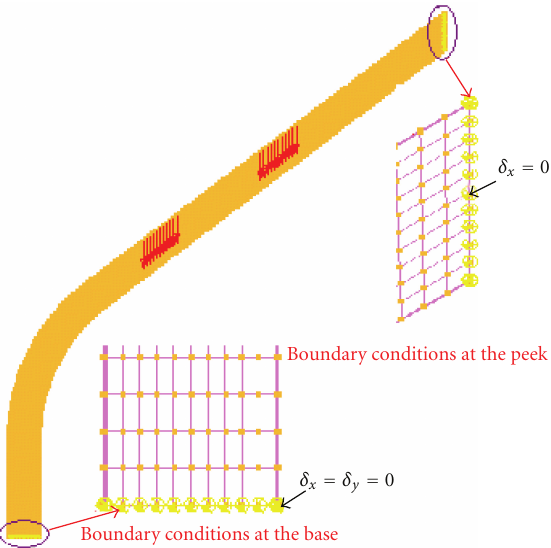
Figure 5: Glulam arch finite element boundary